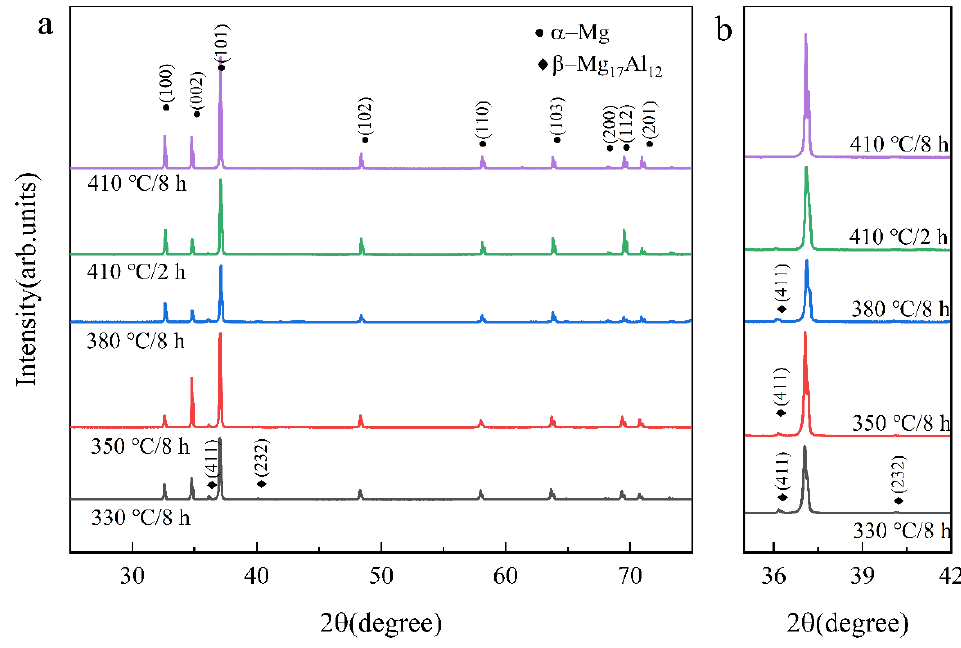
Figure 3. ( a ) XRD spectrum of SLM + T4 AZ61; ( b ) details in 35° – 45°.